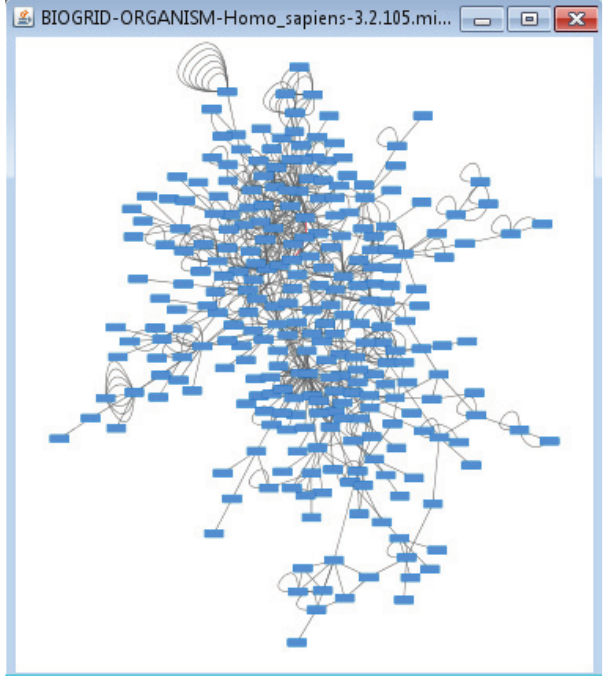
Figure 2. Template H. sapiens before gene expression data.